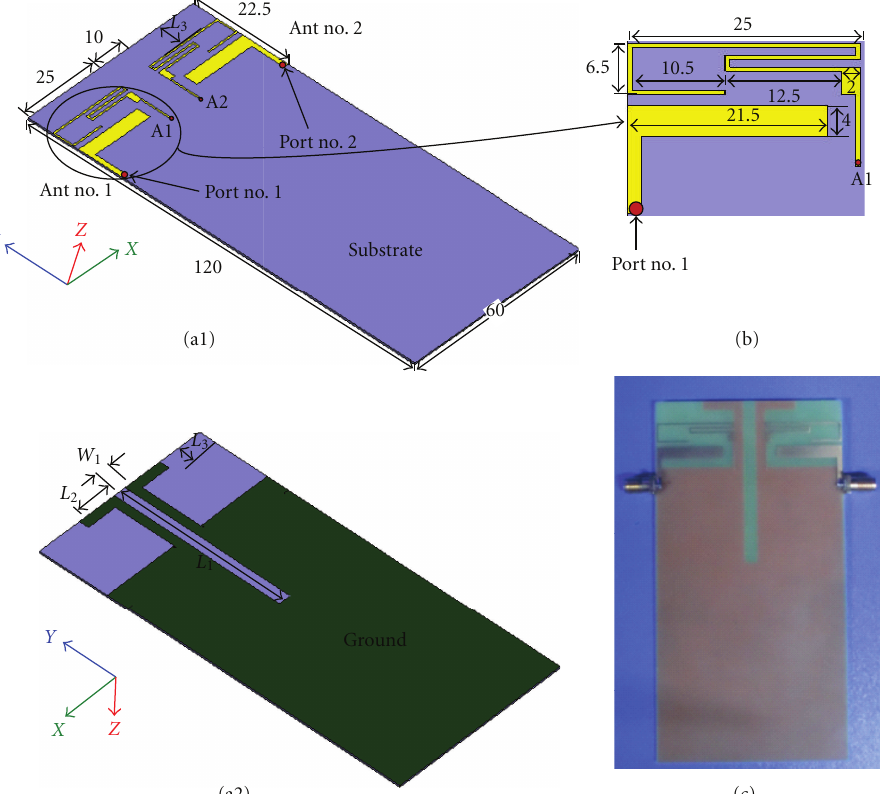
Figure 1: Geometry of the proposed MIMO antenna: (a1) and (a2) 3D view of the proposed MIMO antenna, (b) element antenna structure, and (c) fabricated MIMO